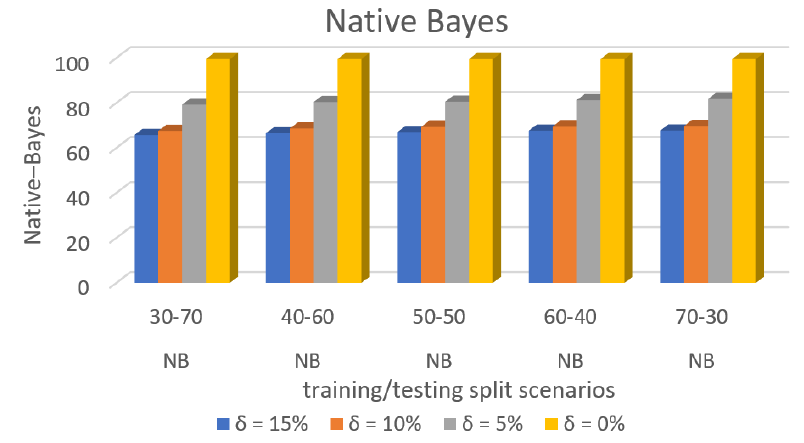
Figure 9. Accuracy Prediction for Dataset 1 using Native Bayes Algorithm.